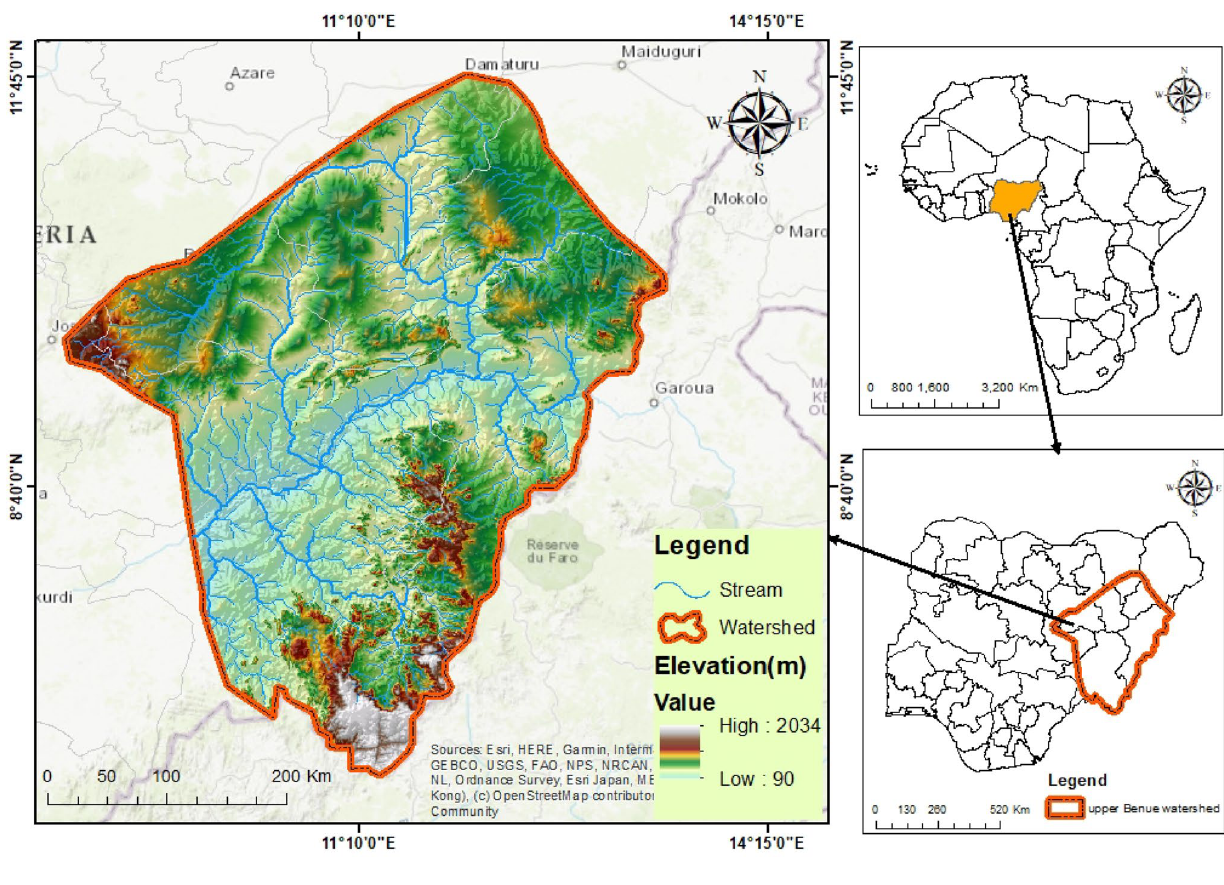
Fig. 1 Location map of the upper benue river watershed Table 1 Data